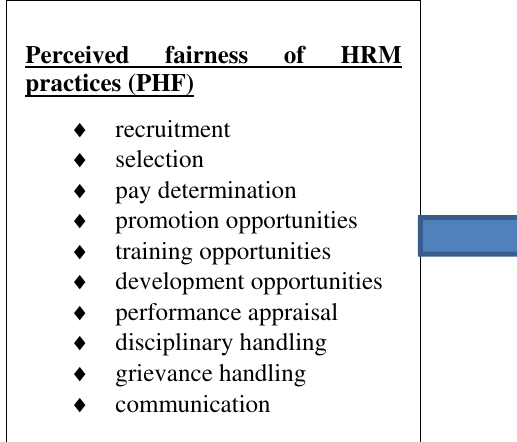
Fig. 1. The conceptual